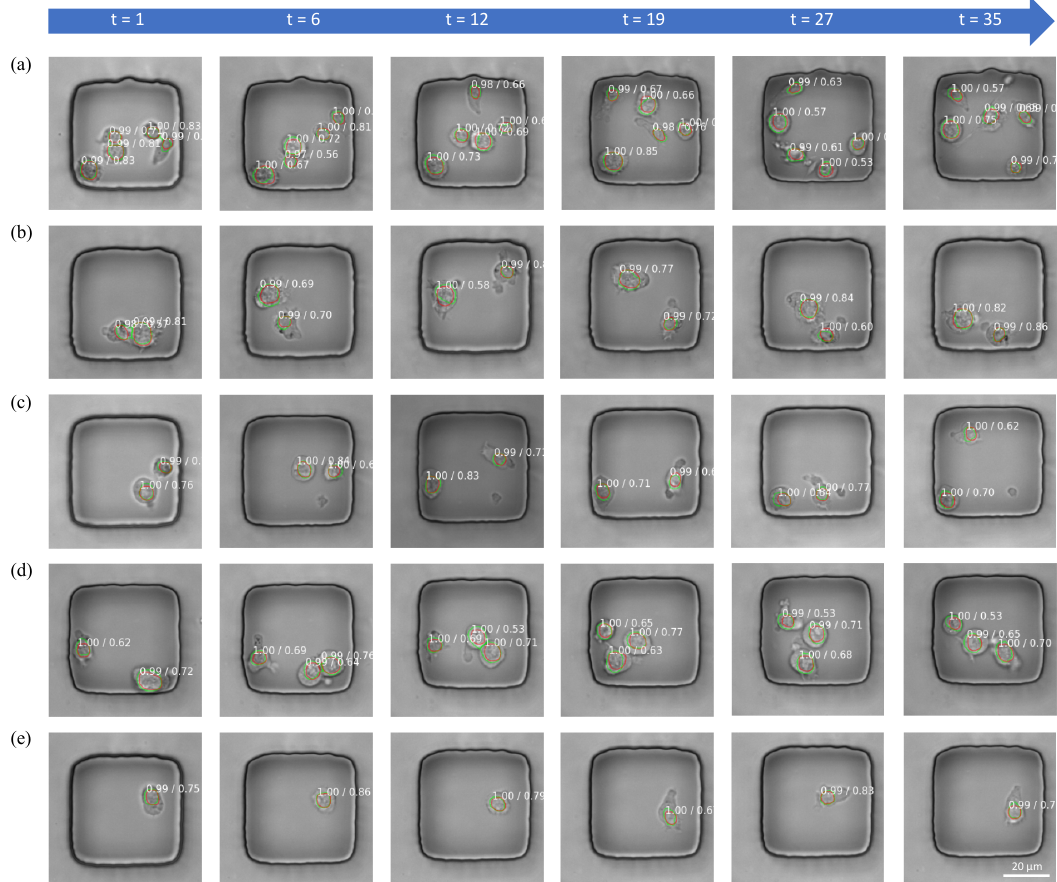
Figure 5. Representative examples of the results of nuclei detection within T cells in 5 nanowells; the annotated number is the prediction score/IoU over the mask. Green lines and red lines denote masks from blob detection and Mask RCNN, respectively. t is the time slot for each phase image being recorded. ( a – e ) are 5 different